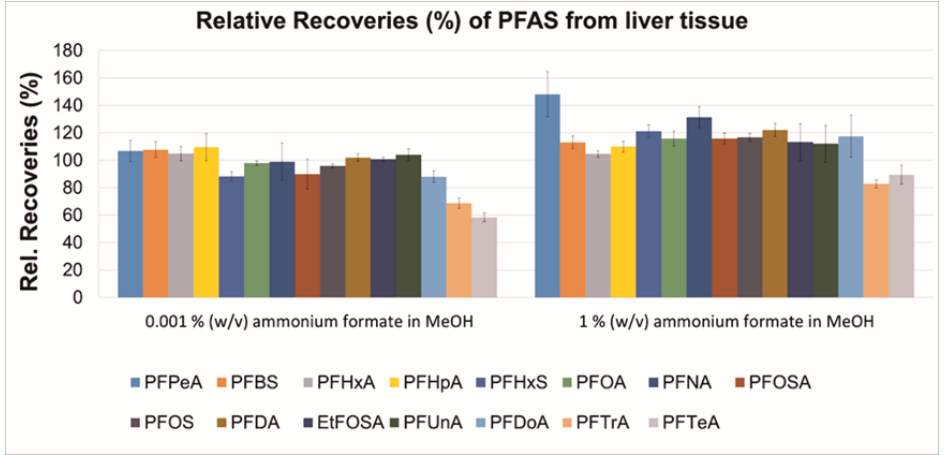
Figure 3. Relative recoveries (%; N = 4) at the fortification amount of 10 ng on pooled harbour porpoise liver tissue with two different concentrations of ammonium formate in MeOH.